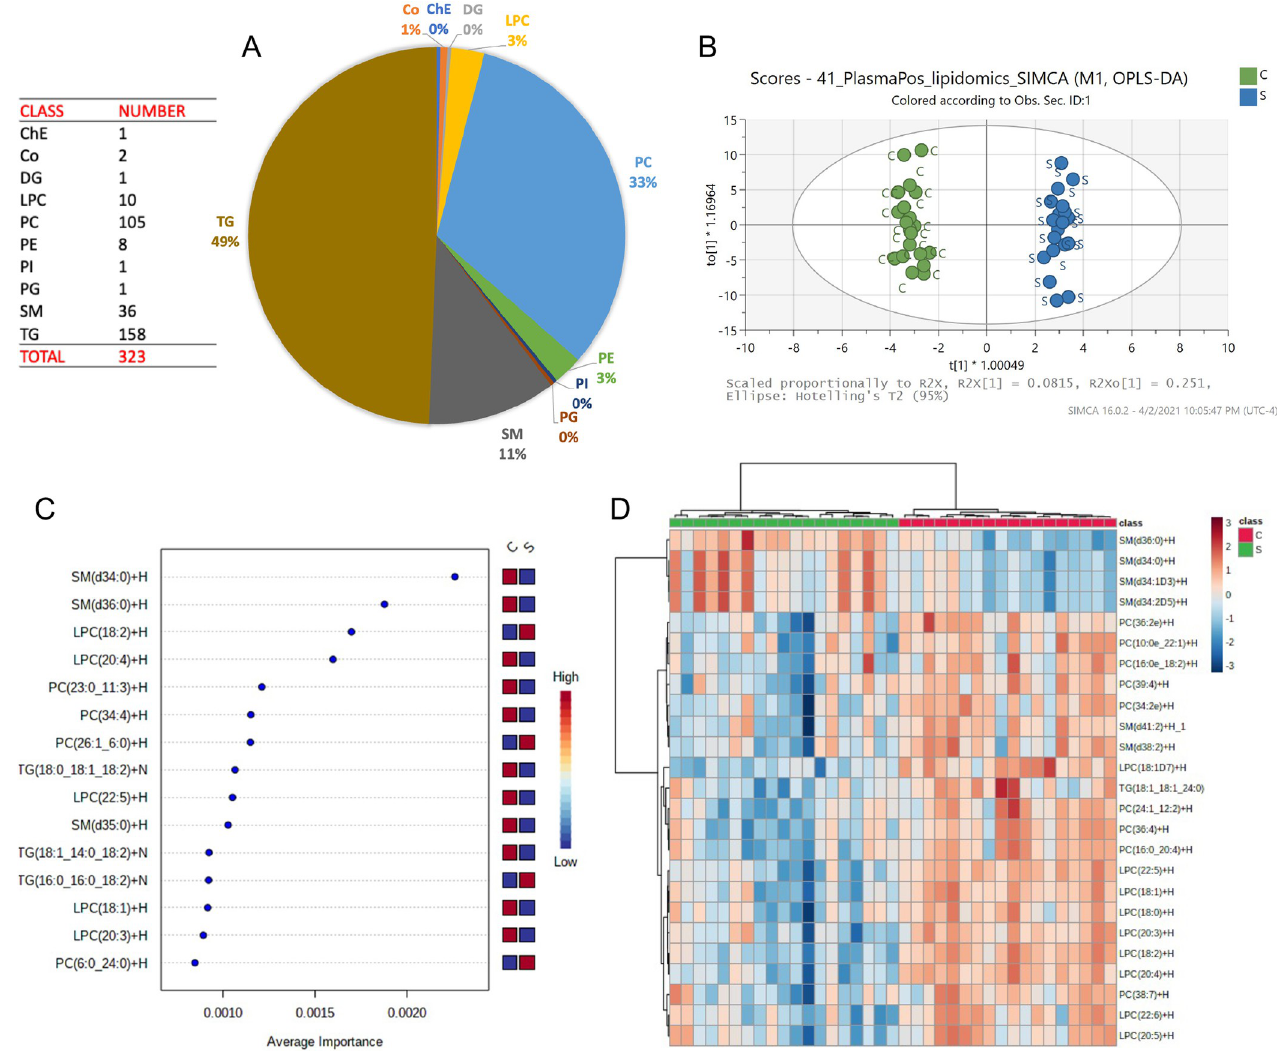
Fig 8. Lipids identified in positive mode 323 lipids (inc. isomers after filtering data). Highest amount corresponded to TG. C30 positive mode: OPLS-DA plot and Heatmap. Multivariate and significant features detection analysis. Compounds detected in C30 positive mode ranked by average